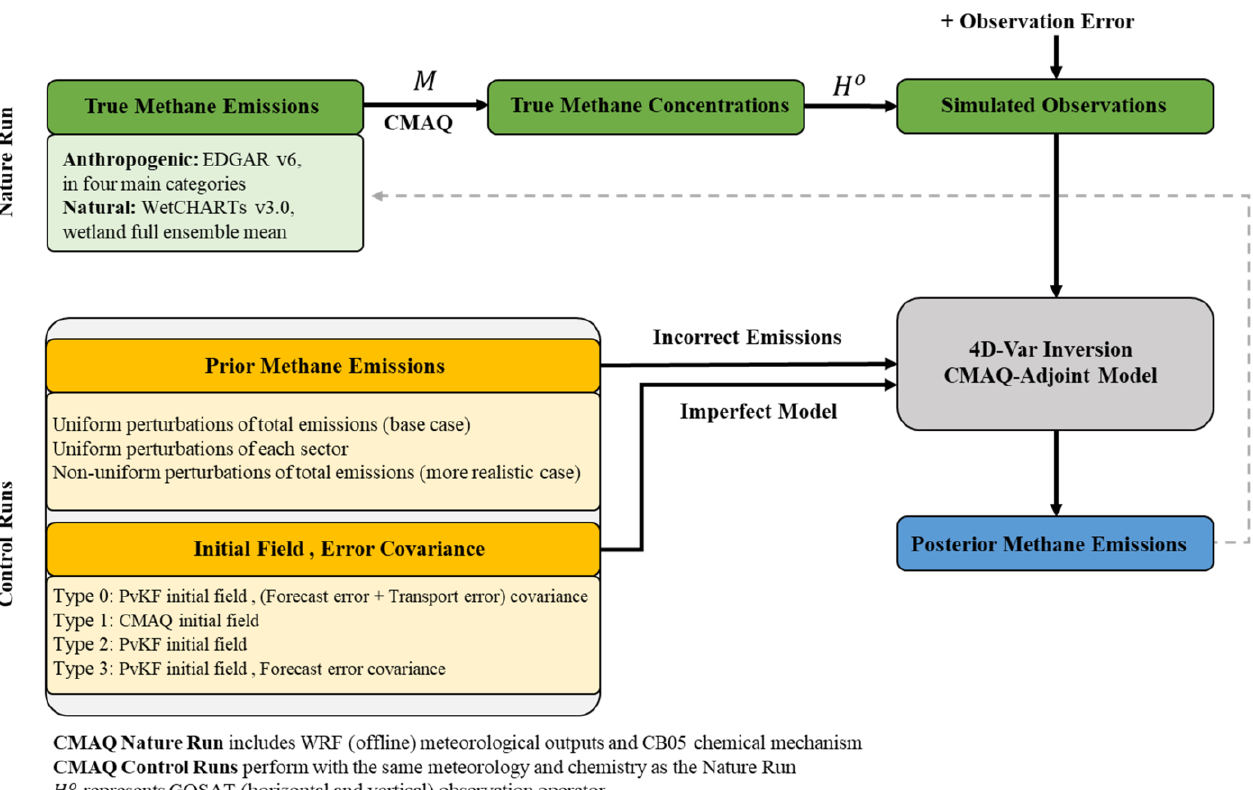
Figure 3. Flowchart of the OSSE framework for optimizing methane emissions.